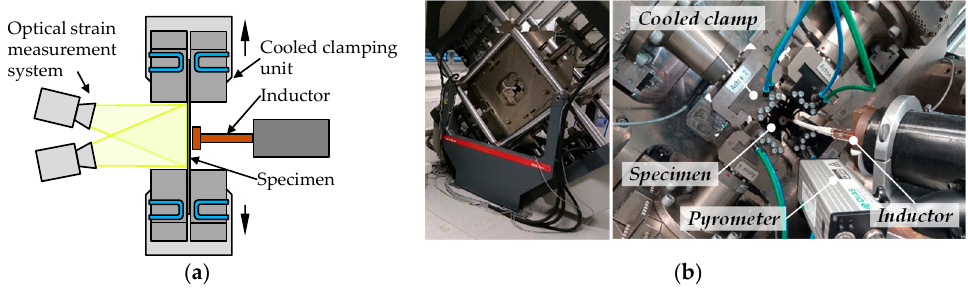
Figure 1. Frictionless formability testing at elevated temperatures: ( a ) test principle with local inductive specimen heating and optical strain measurement in cross-sectional view; ( b ) biaxial tensile testing machine and experimental setup.